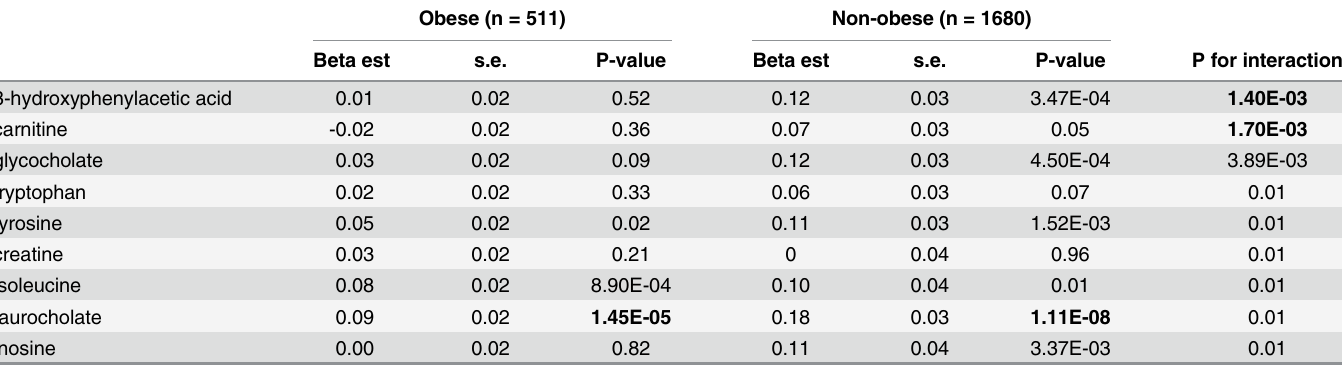
Table 5. Association of metabolite profiles and HOMA-IR in obese and non-obese